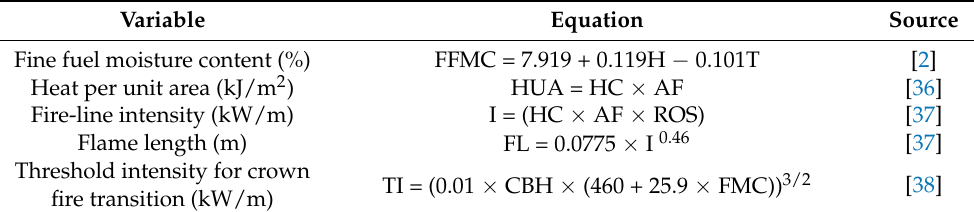
Table 3. Equations used for the estimation of fire behavior parameters. Variable Equation Source Fine fuel moisture content (%) FFMC = 7.919 + 0.119H − 0.101T [2] HUA = HC × AF [36] [37]